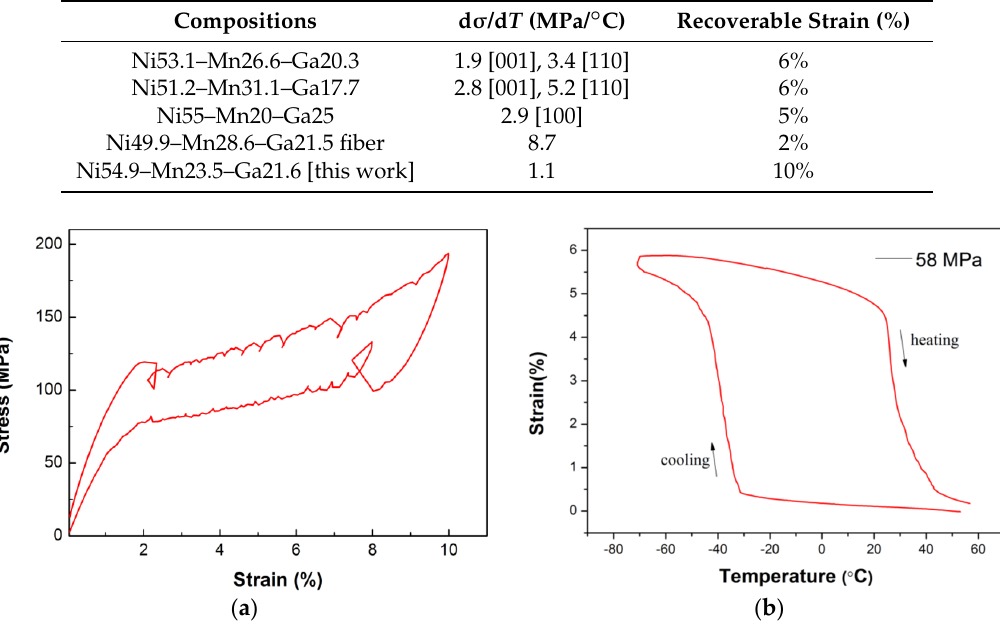
Figure 7. ( a ) Stress–strain curves for Ni54.9–Mn23.5–Ga21.6 fiber unloaded from 10% strain at 40 °C ( b ) Stress ‐ assisted shape memory effect of the Ni54.9–Mn23.5–Ga21.6 fiber under constant tensile load of 0.05 N(~58 MPa).